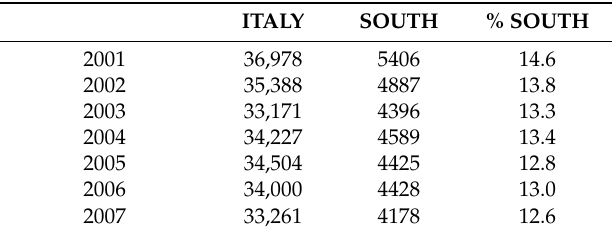
Table 1. Sample composition for year and for sized